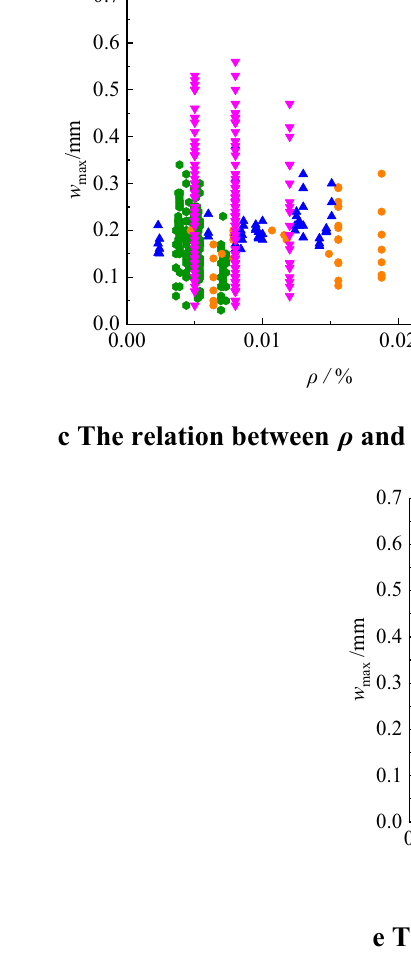
Fig. 20 Comparison of w max and different parameters such as σ s , d , ρ , c , f cu from RC beams with 335 MPa–600 MPa steel